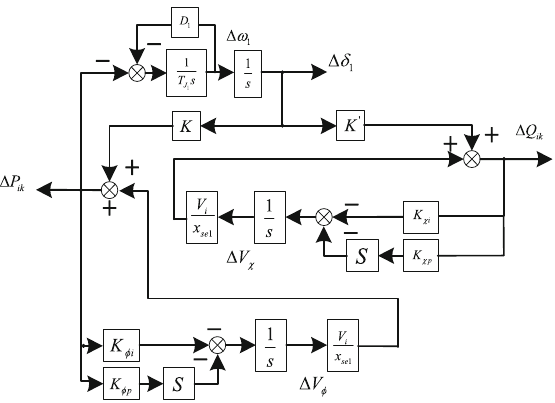
Fig. 3 Block diagram of system transfer function with